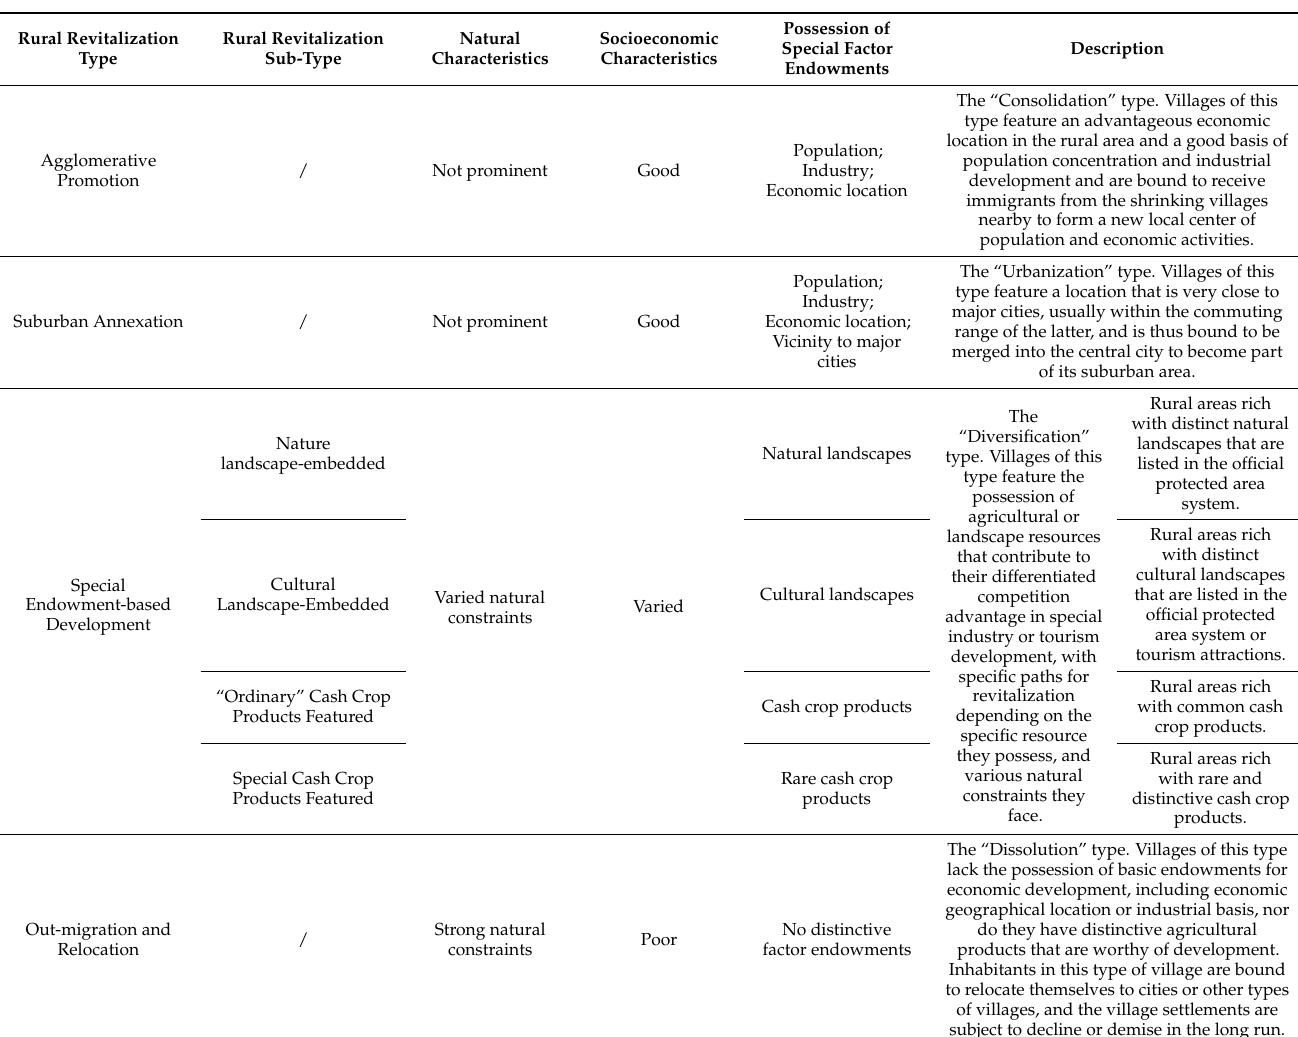
Table 3. Rural Revitalization Types and